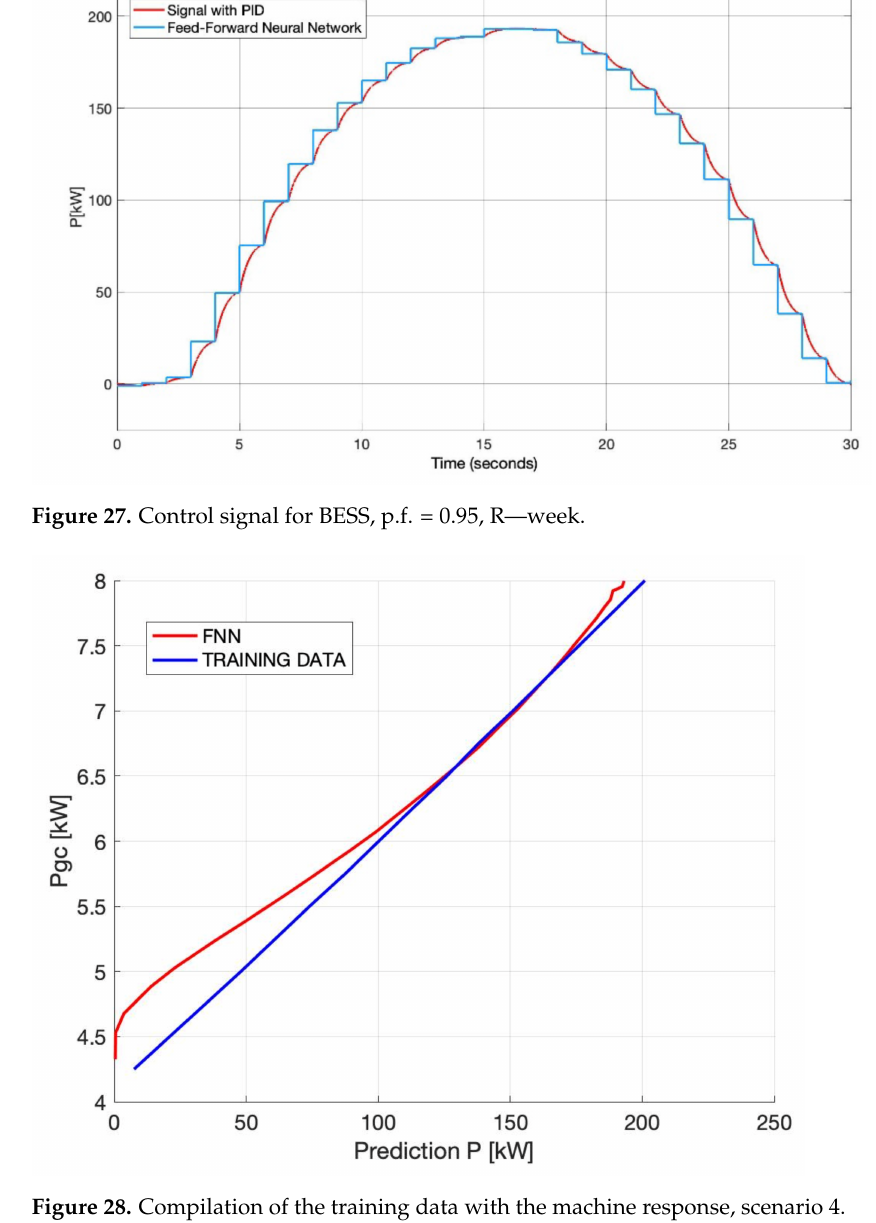
Figure 28. Compilation of the training data with the machine response, scenario